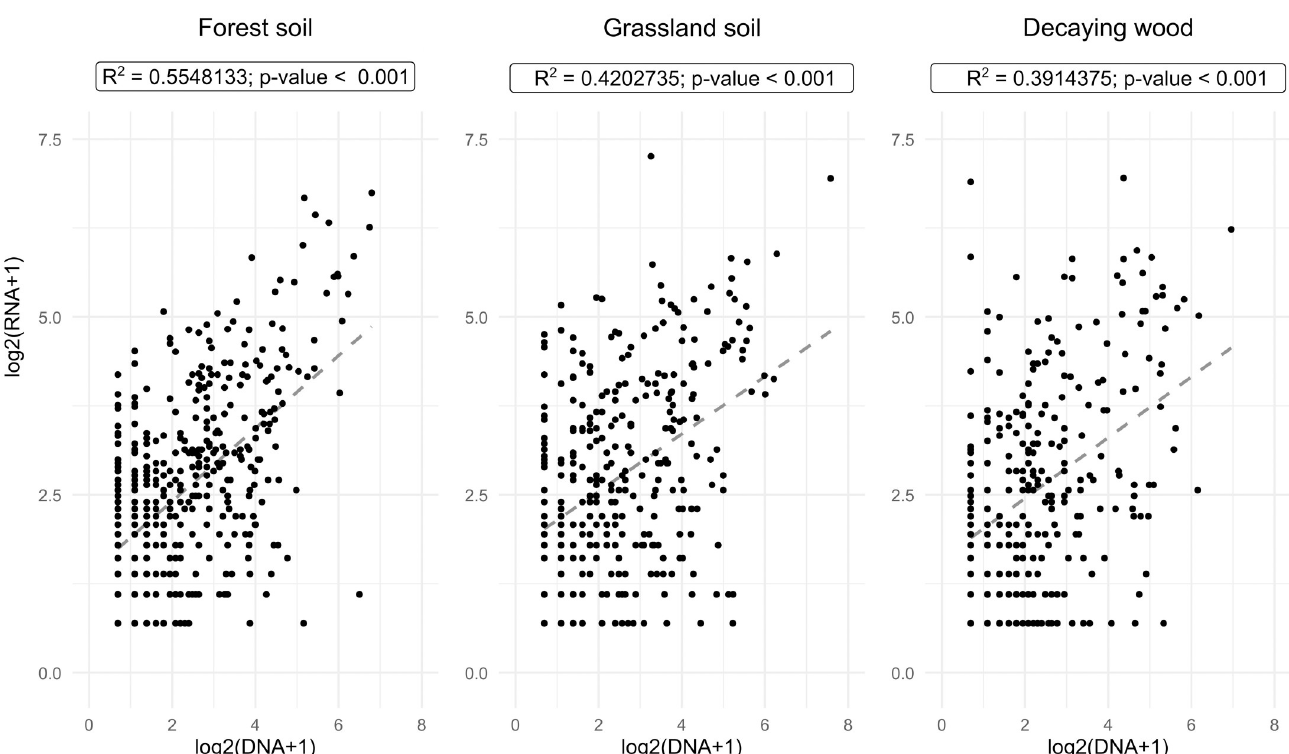
Fig 3. Correlations between DNA and RNA MOTUs read abundance in each of the three habitats. Log2-transformed DNA and RNA reads abundances of each MOTU are plotted against each other. Linear coefficient of correlations (R 2 ) and their level of significance, as well as linear trend-lines (dashed lines) are given. https://doi.org/10.1371/journal.pone.0244682.g003 The partition of MOTUs across different habitats in the “shared” dataset was visualized in ternary plots using reads abundance in either the DNA or RNA datasets (Fig 5A). Both plots showed a higher concentration of MOTUs on the grassland-woodland soil edges of the trian- gles, which was consistent with the observation that these two habitats are difficult to distin- guish in pairwise comparisons. On the opposite, the grassland soil-decaying wood edges of the triangles were characterized by the lowest density of MOTUs. Finally, we performed Table 2. Pairwise comparisons (two ways PERMANOVAs) between habitats using different MOTU datasets. Habitats pairwise comparison Dataset Forest vs Grassland soil Forest soil vs Wood Grassland soil vs Wood All reads 0.63 0.003 shared DNA (shared) component RNA (shared)